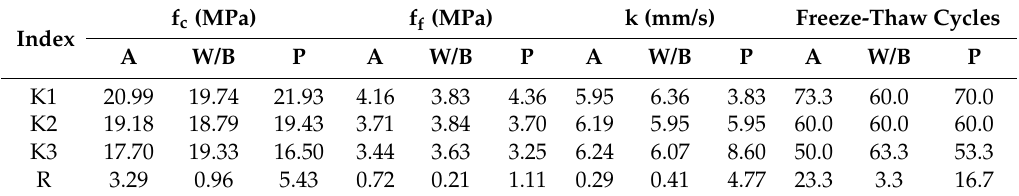
Table 5. Range analysis results; A: aggregate size; W/B: water-binder ratio; P: porosity